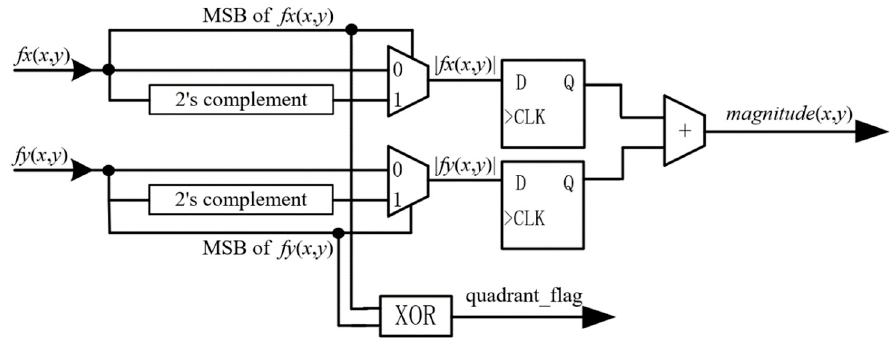
Figure 7. Architecture of the gradient magnitude calculation and quadrant_flag computation.